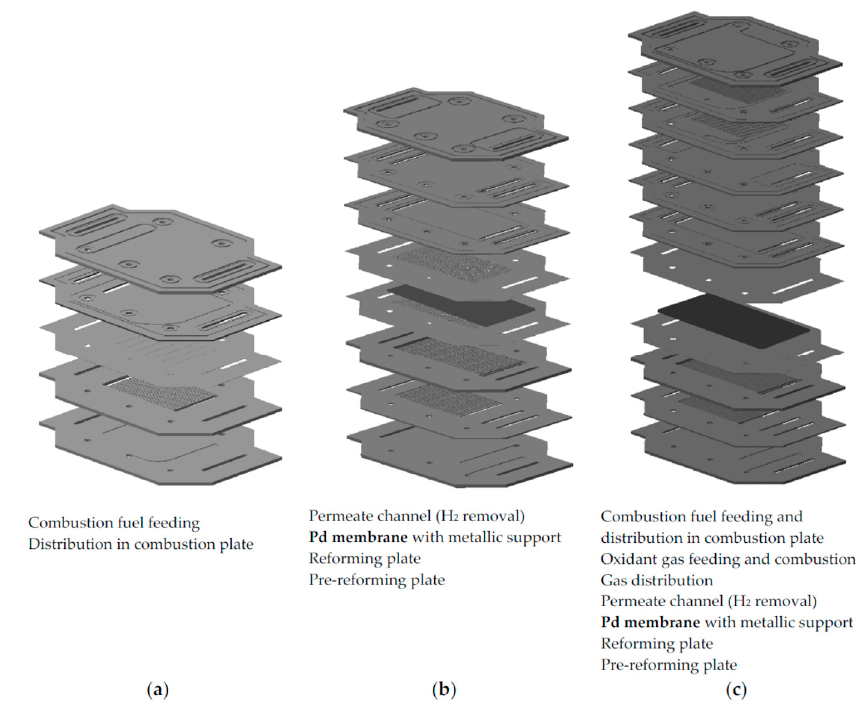
Figure 8. ( a – c ) Stack designs for combustion, reformer, and integrated module for the reforming of methane with integrated hydrogen separation. Reproduced from [30].